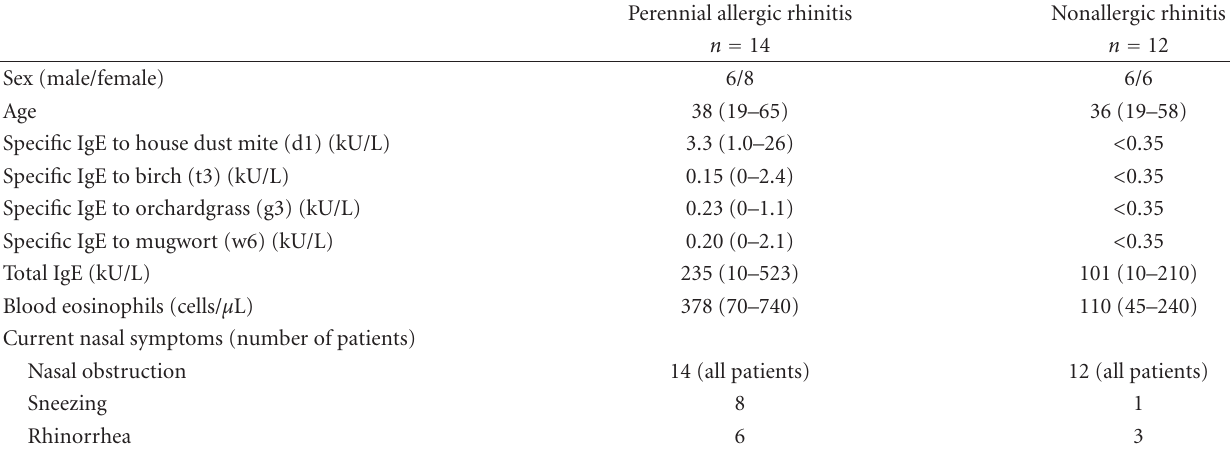
Table 1: Demographic characteristics of perennial allergic and nonallergic